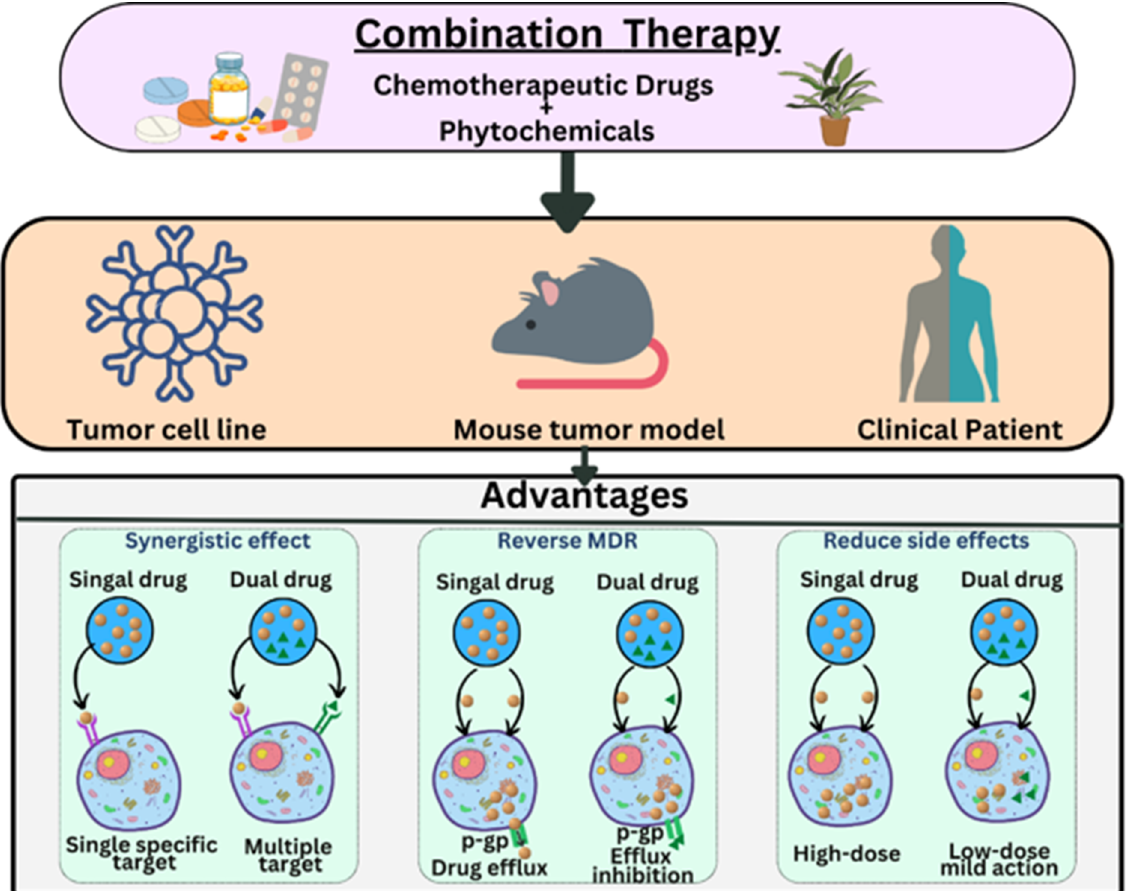
Figure 5. Advantages of codelivery of anticancer drugs with phytochemicals.